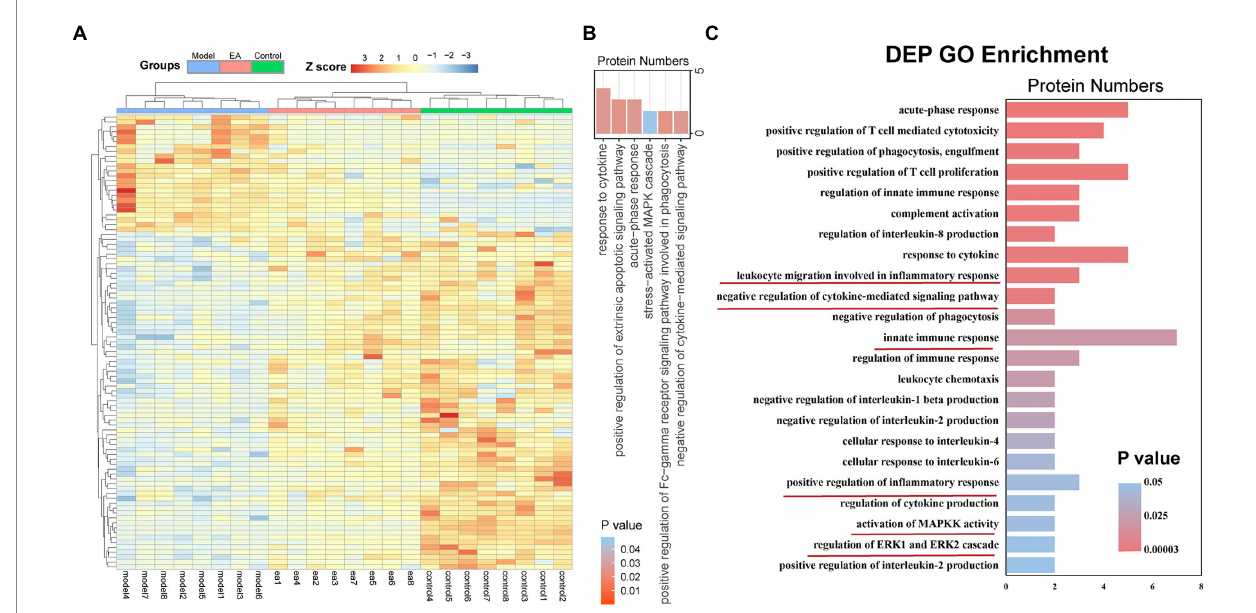
FIGURE 2 EA regulates the inflammatory response in the synovium of KOA rats. The features of differentially expressed proteins (DEPs) of the synovitis in the model group compared with those of the EA group. (A) DEP profiles were hierarchically clustered and shown as a heatmap wherein 222 proteins were up-regulated (red) or down-regulated (blue). (B) Gene ontology analysis of DEPs: Enriched with terms of response to cytokine, positive regulation of extrinsic apoptotic, signaling pathway, acute-phase response, stress − activated MAPK cascade, positive regulation of Fc-gamma receptor signaling pathway involved in phagocytosis, and negative regulation of cytokine − mediated signaling pathway. (C) Gene ontology analysis of DEPs: Enriched in terms related to immune regulation and response ( n = 8): cellular response to IL-6, negative regulation of interleukin-1 beta production, negative regulation of cytokine-mediated signal pathway, the regulation of innate immune response, leukocyte migration involved in the inflammatory response, positive regulation of inflammatory response, activation of MAPKK activity, and regulation of ERK1 and ERK2